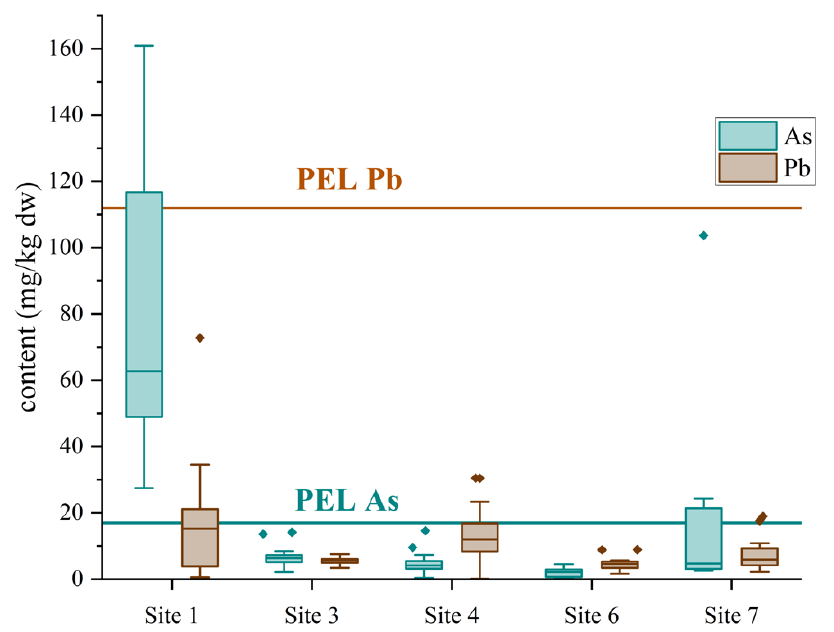
Figure 5. Box plot, as well as the probable effect level (PEL) for Ni and Zn, indicated with straight lines in sediments from sites along the course of the mining-influenced water.